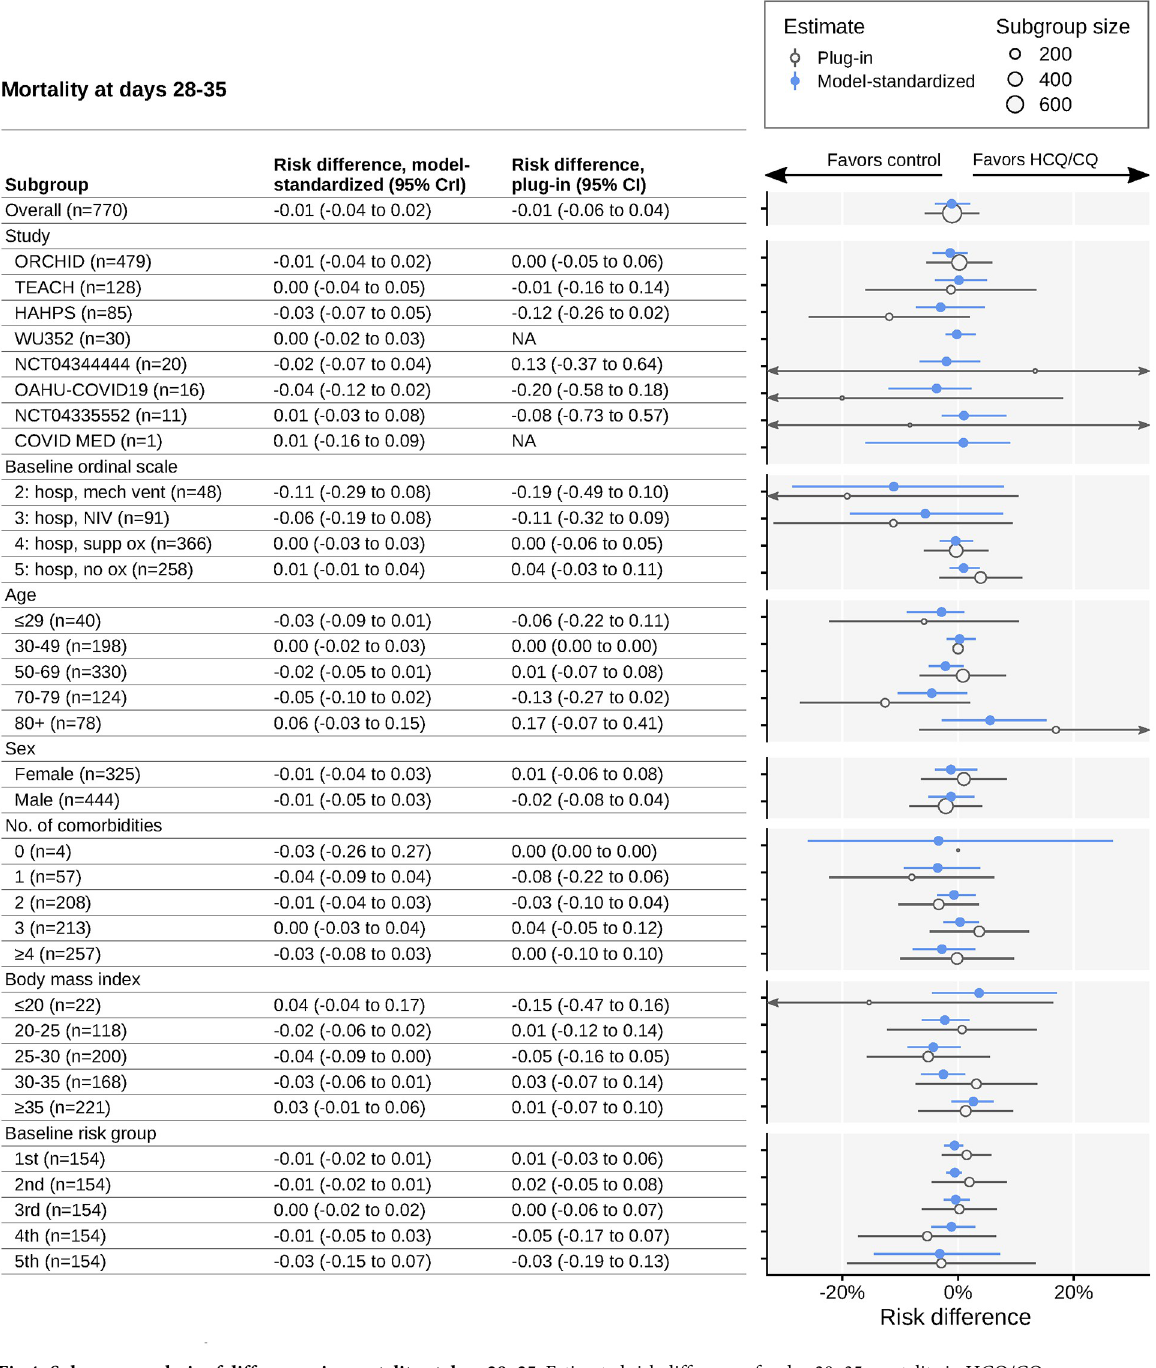
Fig 4. Subgroup analysis of differences in mortality at days 28–35. Estimated risk differences for day 28–35 mortality in HCQ/CQ versus control groups. Estimates are given for the pooled patient population and for subgroups. Blue circles represent model-standardized estimates; blue horizontal lines represent 95% credible intervals. Open grey circles represent plug-in estimates; grey horizontal lines represent 95% CIs. Grey circle size represents the number of patients in the corresponding subgroup. Arrows indicate uncertainty intervals extending beyond plot limits. Study acronyms are explained in Fig 1. Two trials did not have study acronyms (only trial registration numbers). Abbreviations: 95% CrI, 95% credible intervals; HCQ/CQ, hydroxychloroquine or chloroquine; NA, not applicable; NIV, noninvasive ventilation (includes BiPAP/CPAP and/ or high-flow oxygen); OR, odds